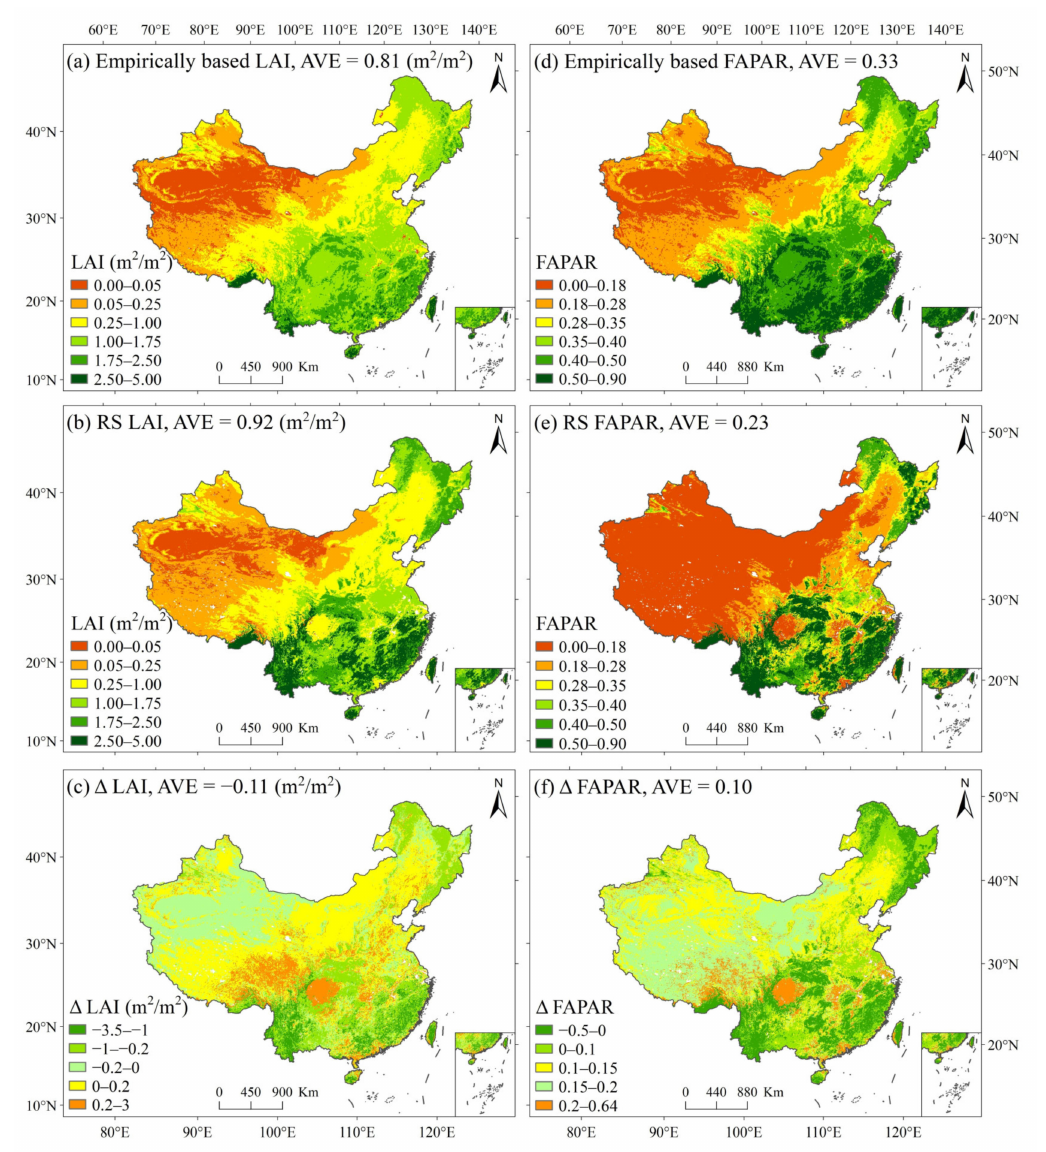
Figure 3. The spatial pattern of mean annual (1982–2015) LAI estimated by the empirical method ( a ) and RS (GLASS) product ( b ), and their differences ( ∆ LAI) ( c ). The right column ( d – f ) is same as the left column, but for the FAPAR. AVE: National